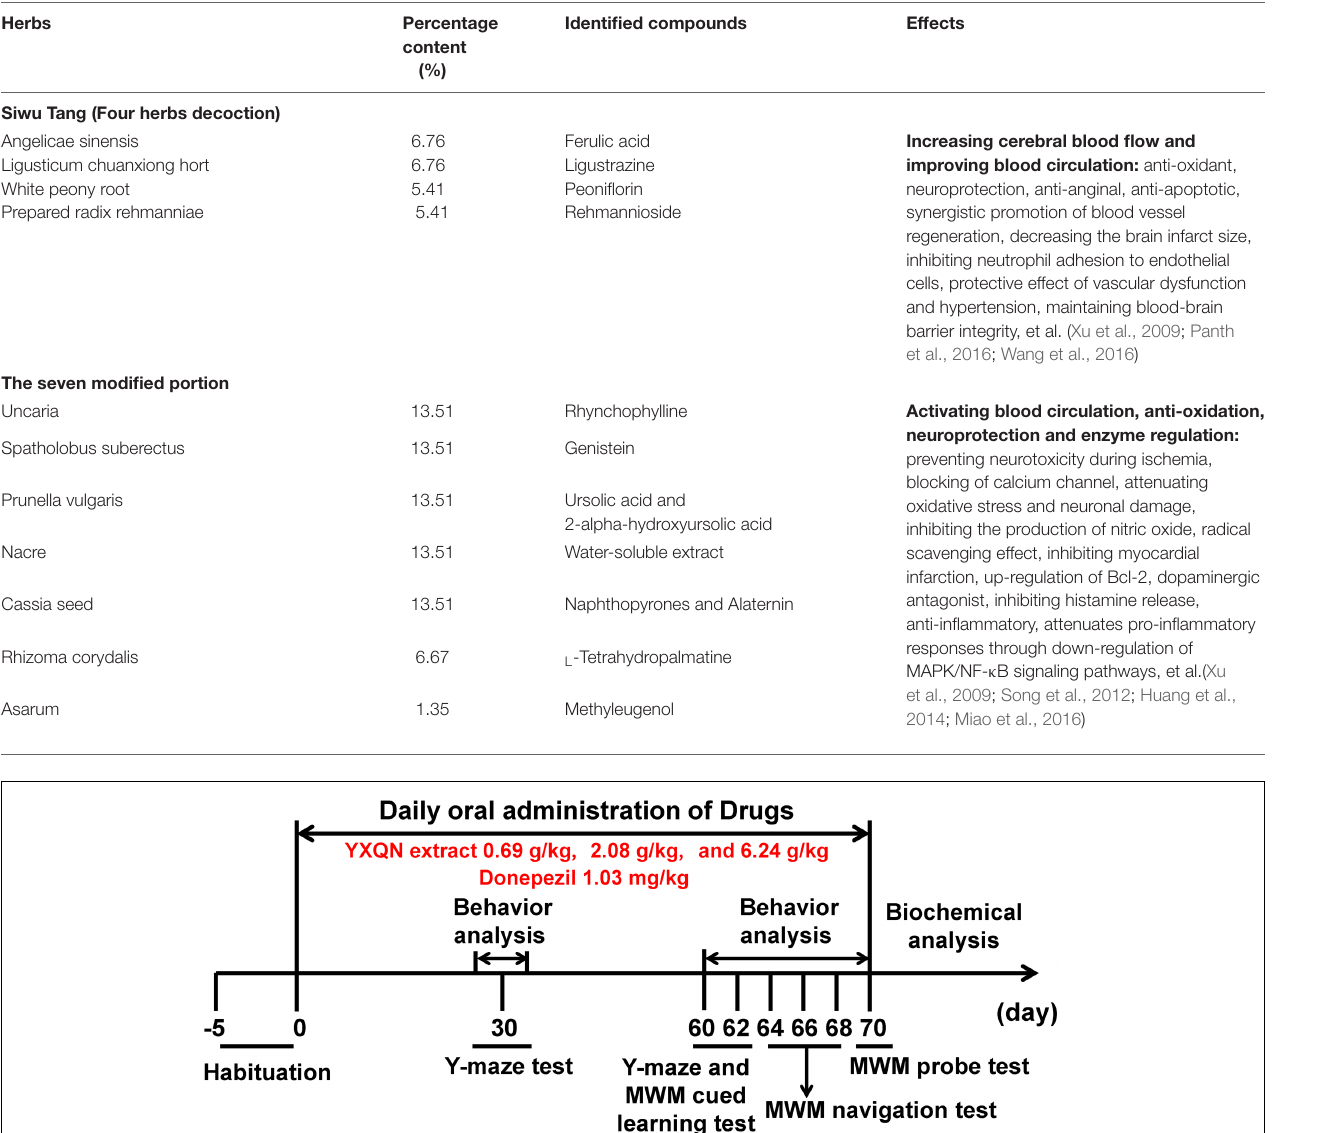
TABLE 1 | Characterization of the herbs included in YXQN.